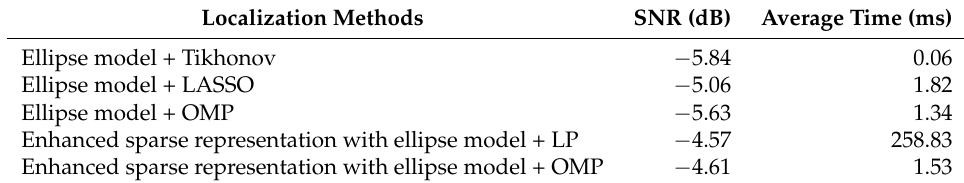
Figure 3. Average localization accuracy in the outdoor scenario. Table 1. Comparison of average signal-to-noise ratio (SNR) and time consumption in the outdoor scenario.